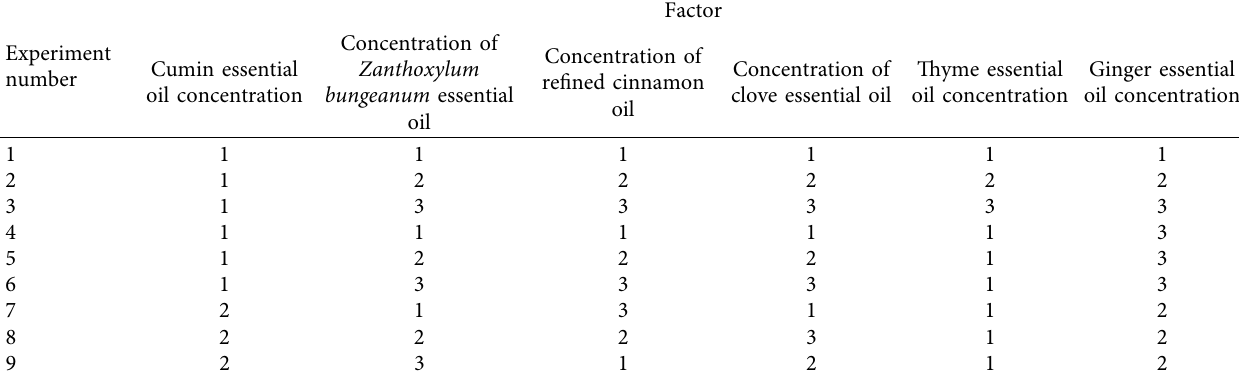
Table 1: Orthogonal experiment table of six essential